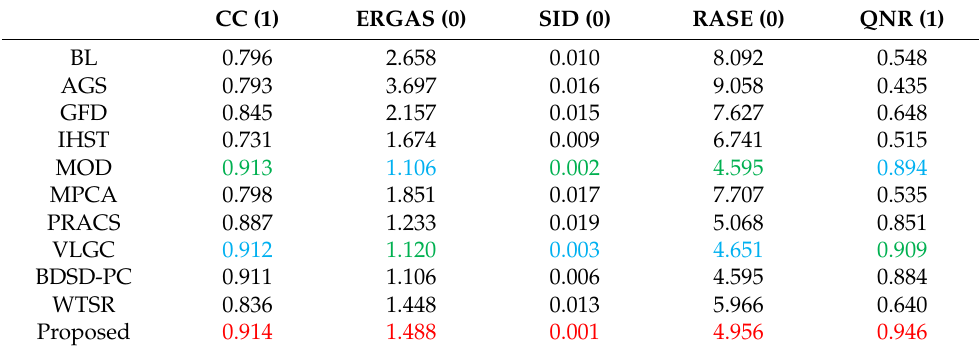
Table 3. The third group of quantitative results.